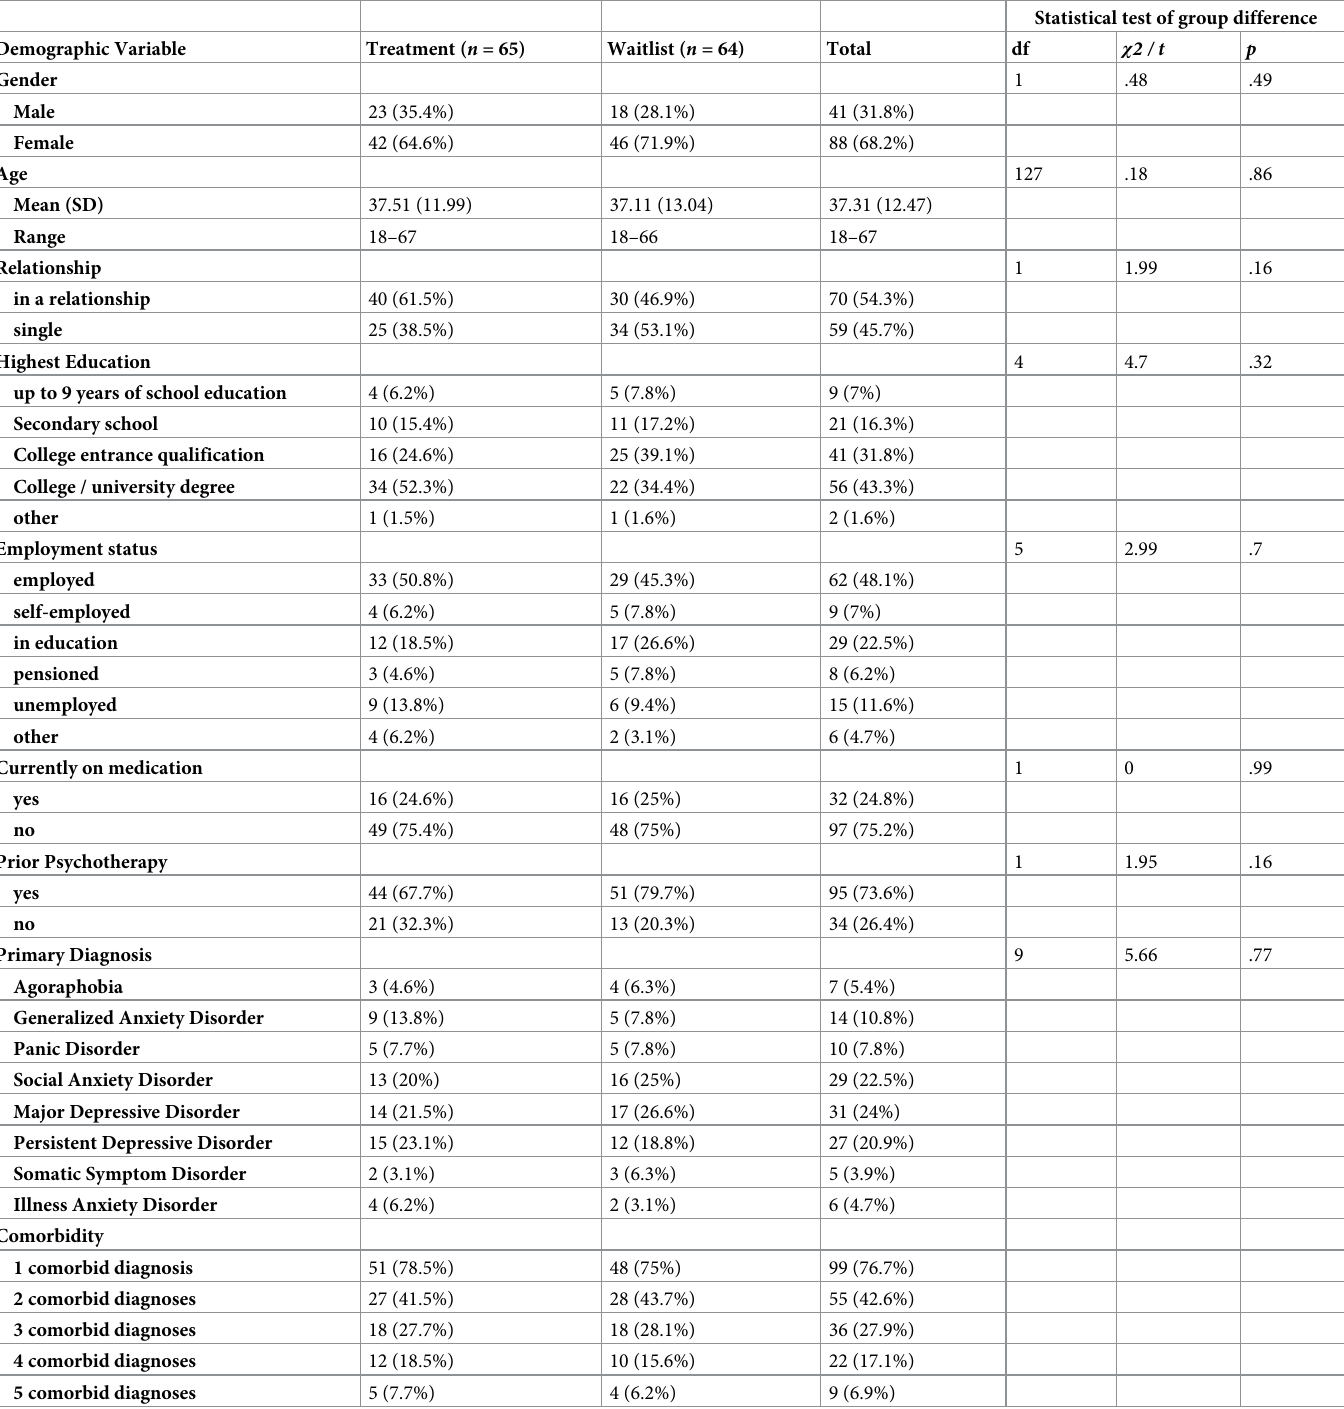
Table 2. Demographic characteristics of participants at